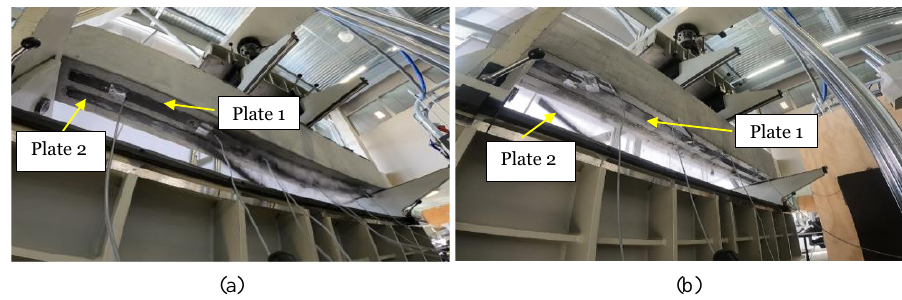
Figure 9. ( a ) Simultaneous failure of two CFRP plates in the B.0 beam; ( b ) failure of one plate before the other in the A.0 beam.